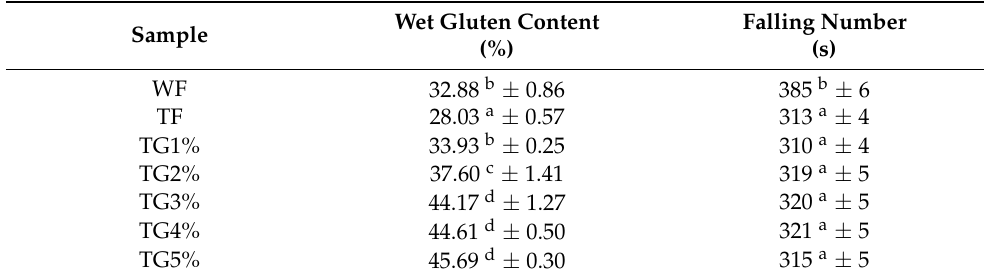
Table 1. Gluten content and falling number of wheat flour, triticale flour and system of triticale flour with vital